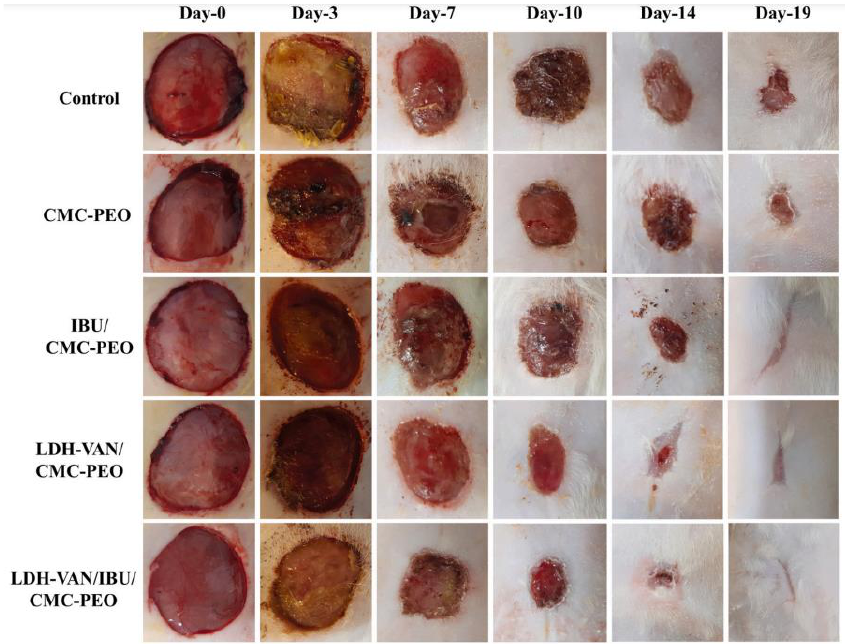
Figure 19. Representative photographs of wounds treated by control, CMC-PEO, and IBU/CMC- PEO, LDH-VAN/CMC-PEO, and LDH-VAN/IBU/CMC-PEO groups on days 0, 3, 7, 10, 14, and 19. (reprinted from Yoosefi et al. [269] with permission of Elsevier).